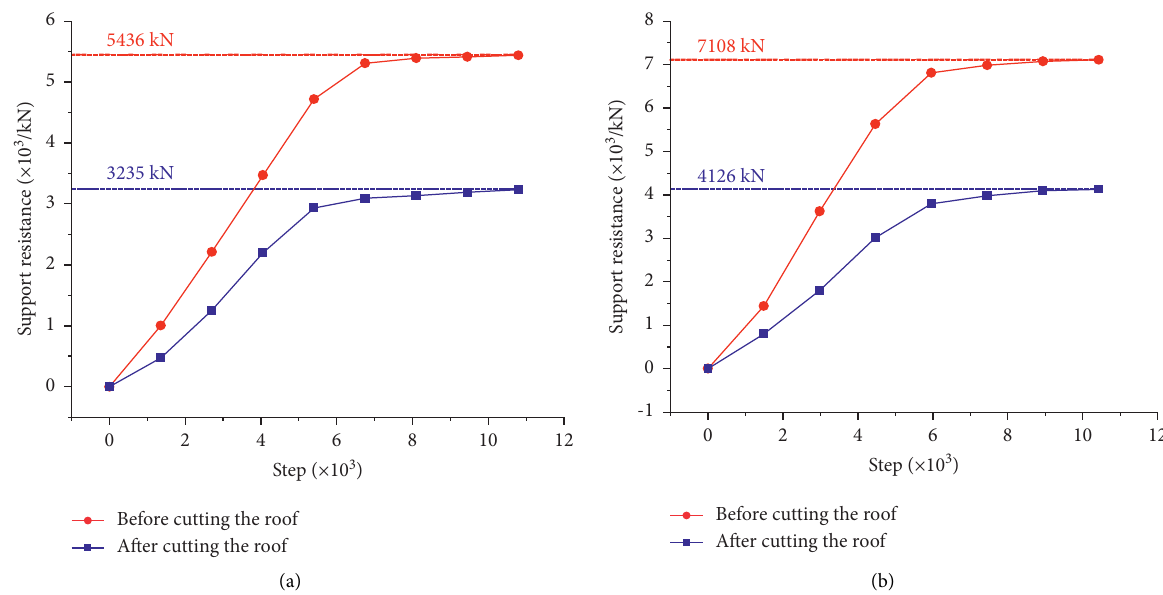
Figure 10: Curves of the working resistance of the support before and after the top cut. (a) Distance of 5.275m from the support to the coal wall. (b) Distance of 6.175m from the support to the coal